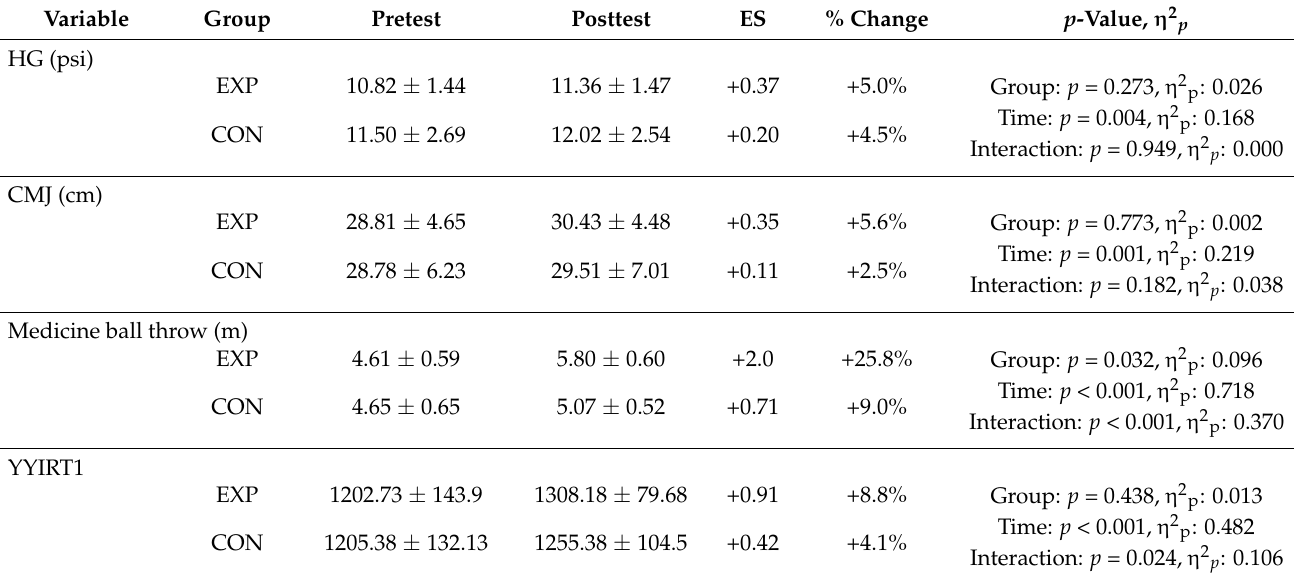
Table 3. Effect of exercise and nutrition intervention on PF